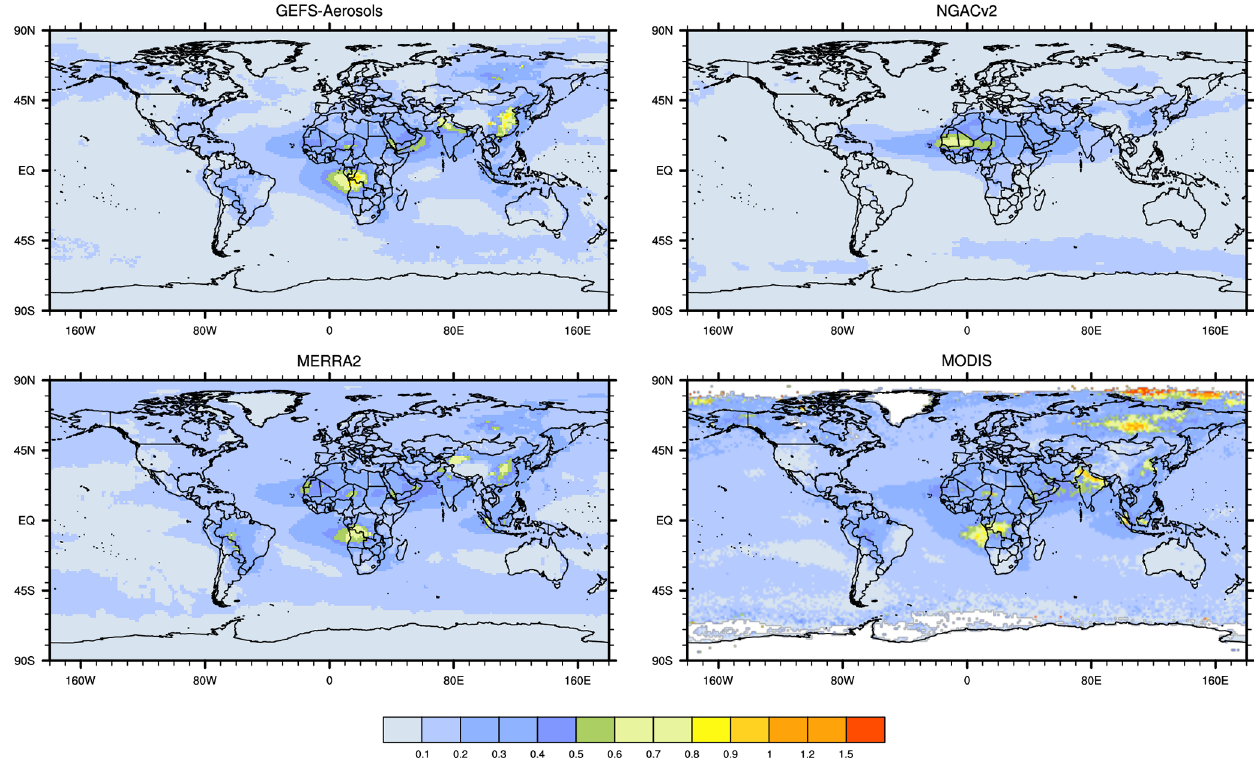
Figure 6. Day-1 AOD prediction averaged during 5 July–30 November 2019 for GEFS-Aerosols and NGACv2 compared to MERRA-2 reanalysis and